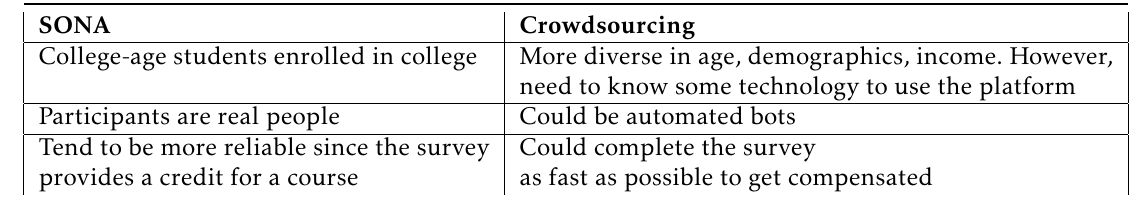
Table 1. The advantages and disadvantages of using SONA and crowdsourcing platforms such as MTurk, CrowdFlower, Clickworkers, and